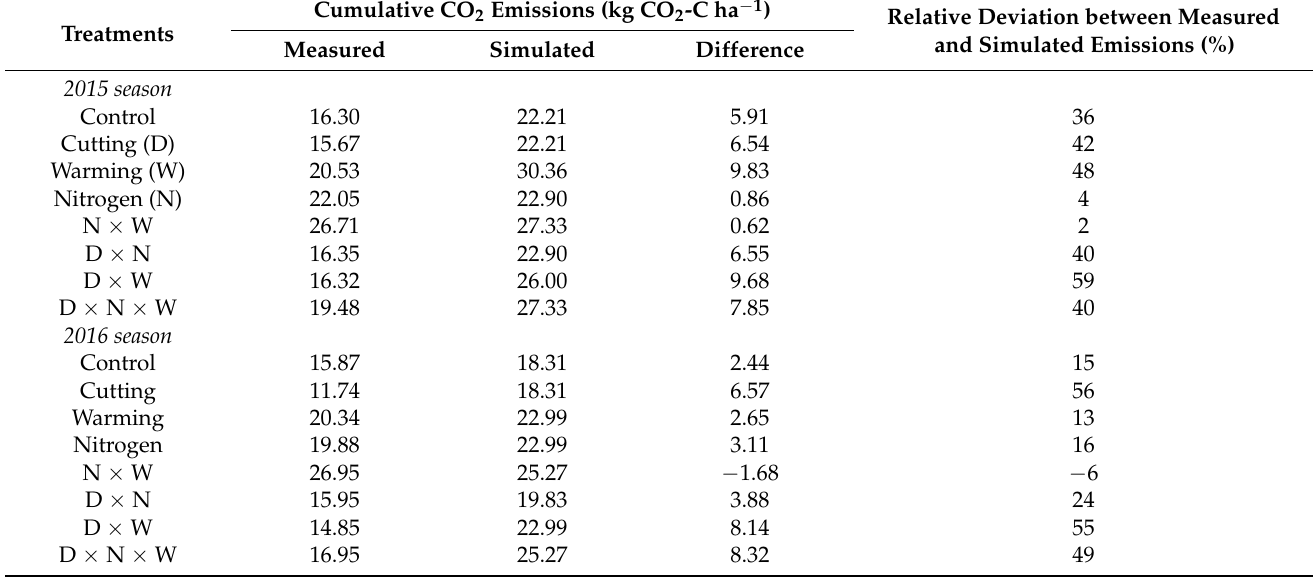
Table 3. Measured and DNDC-simulated cumulative CO 2 emissions (kg CO 2 -C ha − 1 ) for the full factorial experiment over two growing seasons (2015 and